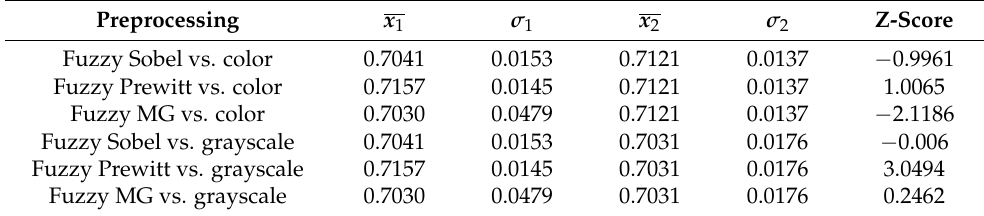
Table 10. Hypothesis test results for CNN-II